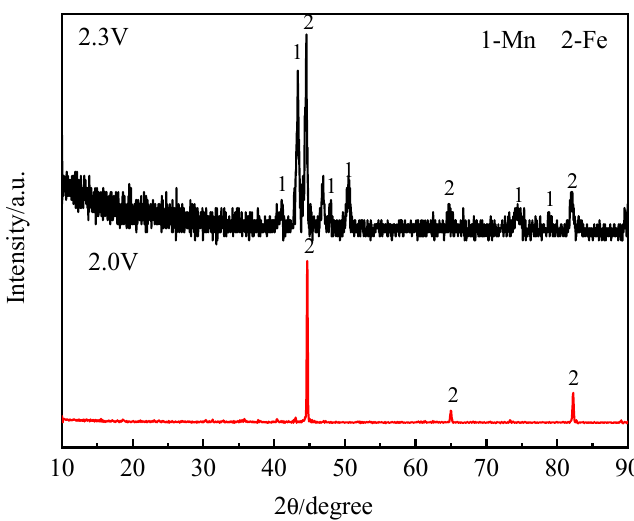
Figure 3. The XRD analysis of the electrodeposited products by electrolysis with di ff erent constant cell